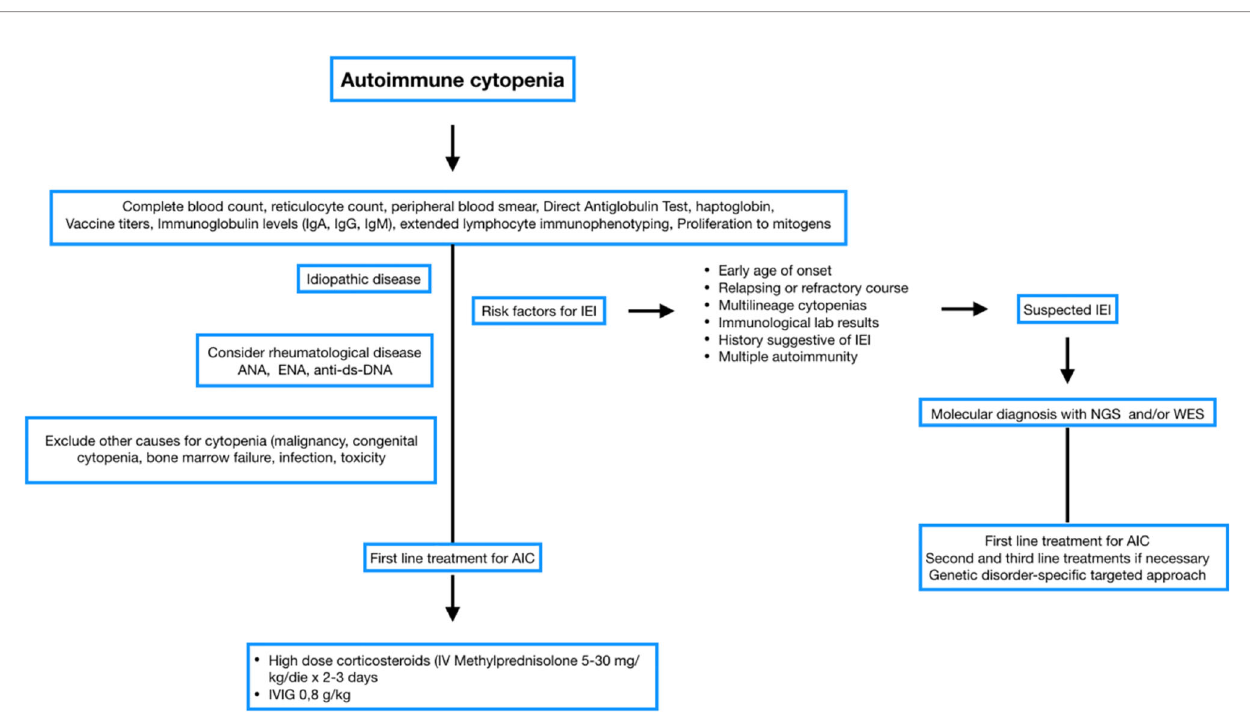
FIGURE 1 | Flow chart Immune cytopenia management. Blood and immunological test at onset. Genetic studies for bilinear cytopenia and